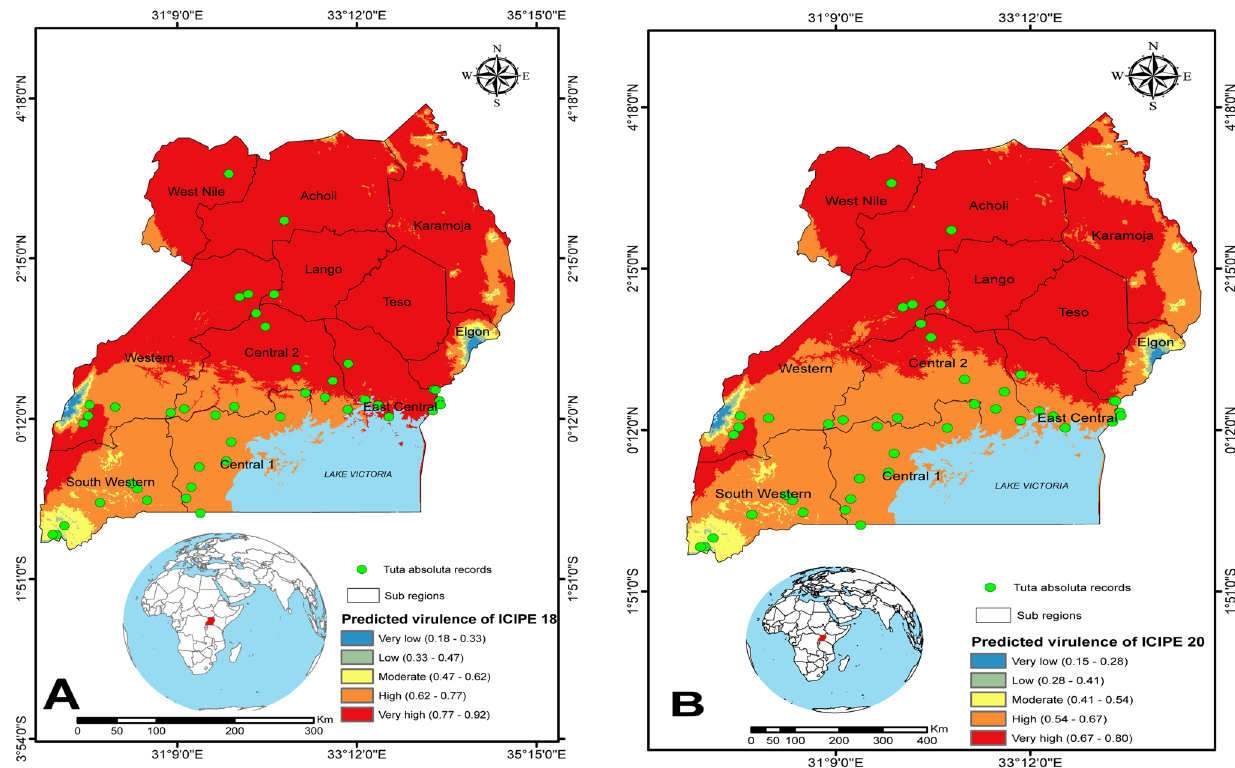
Figure 9. Spatial patterns of predicted virulence of Metarhizium anisopliae isolates ICIPE 18 and ICIPE 20 against adult Tuta absoluta in Uganda: (A) ICIPE 18 and (B) ICIPE 20. The dots in green indicate Tuta absoluta records in the three countries. The figures were generated using the QGIS 3.10.2 software (https:// qgis. org/ downl oads/ 33